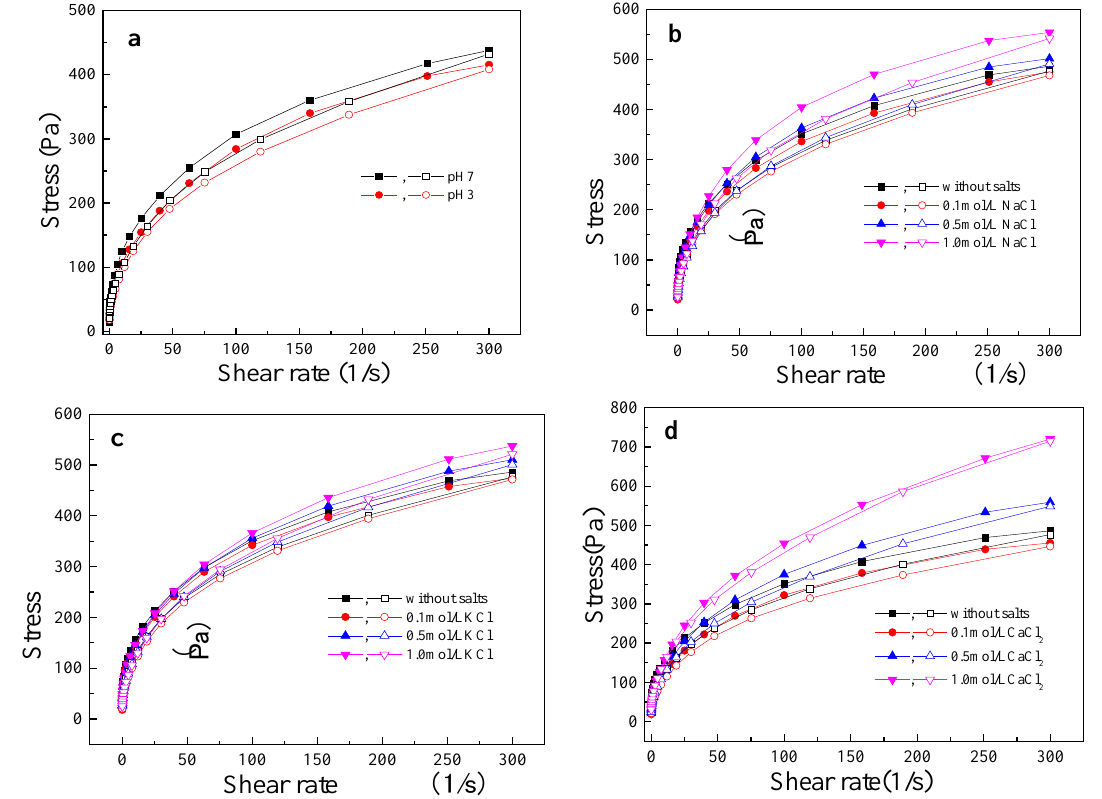
Figure 2. Flow curves of LRS/KGM mixtures in acid or salt solutions. ( a ) acid (citric acid buffer); ( b ) NaCl; ( c ) KCl; ( d ) CaCl 2 . Closed symbols denote the uplink line (the curve of the shear force applied to the sample when the shear rate is varied from 0 s −1 to 300 s −1 ) and opened symbols denote the downlink line (the curve of the shear force applied to the sample when the shear rate varies from 300 s −1 to 0 s −1 ).